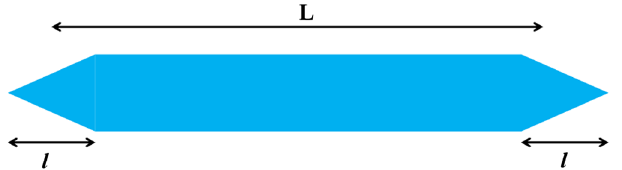
FIG. 20. Schematic of a tapered electrode, where L is the electrode length to be used in Eqs. (2) and (3), and l is the taper